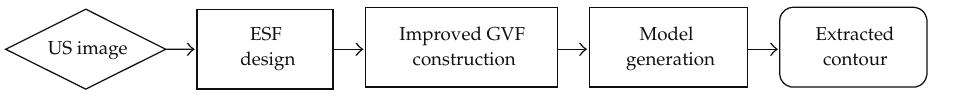
Figure 2: Block diagram of the proposed method for breast tumor